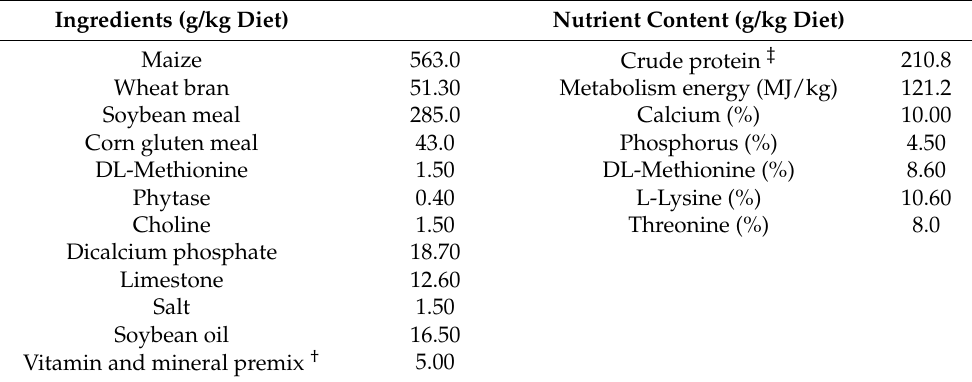
Table 1. Ingredients and nutrient content of the basal diets. Ingredients (g/kg